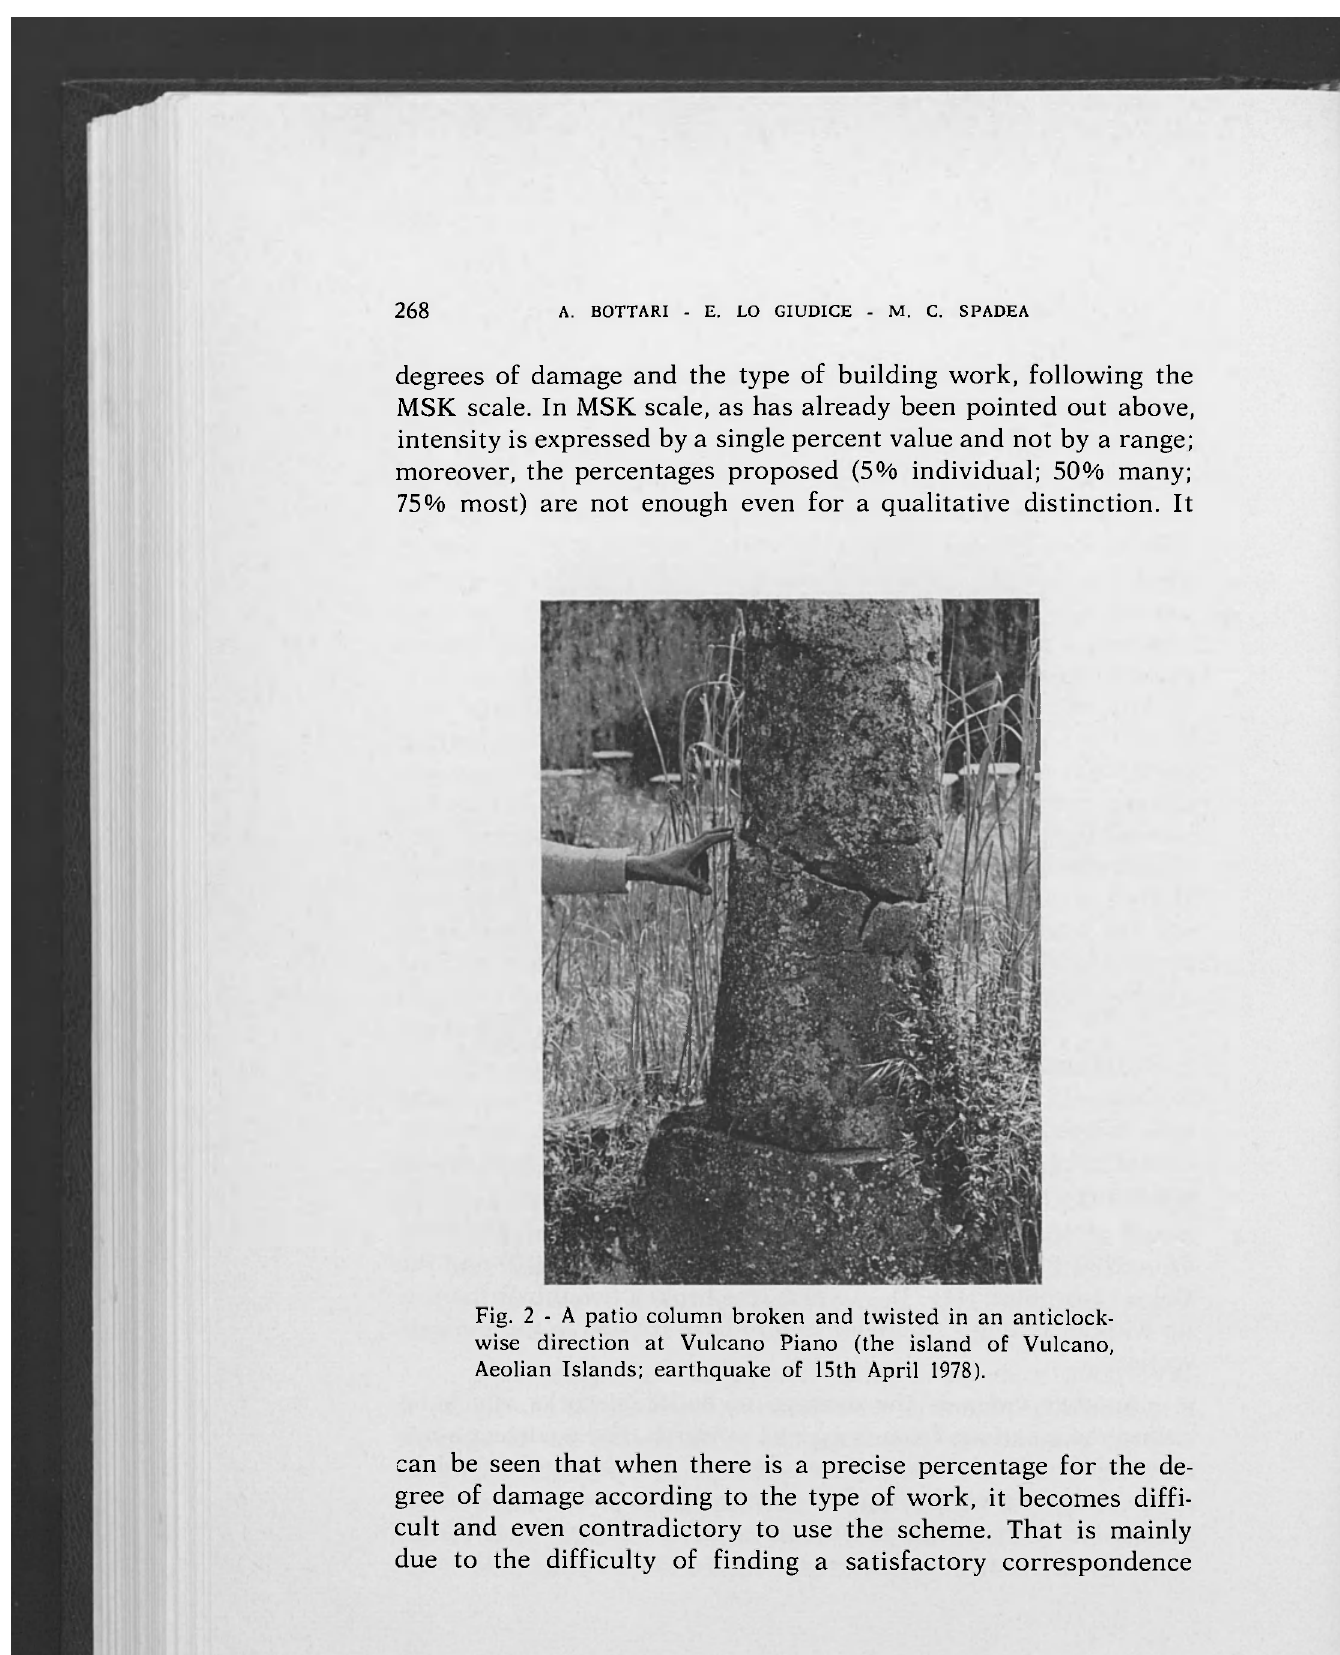
Fig. 2 - A patio column broken and twisted in an anticlock- wise direction at Vulcano Piano (the island of Vulcano, Aeolian Islands; earthquake of 15th April